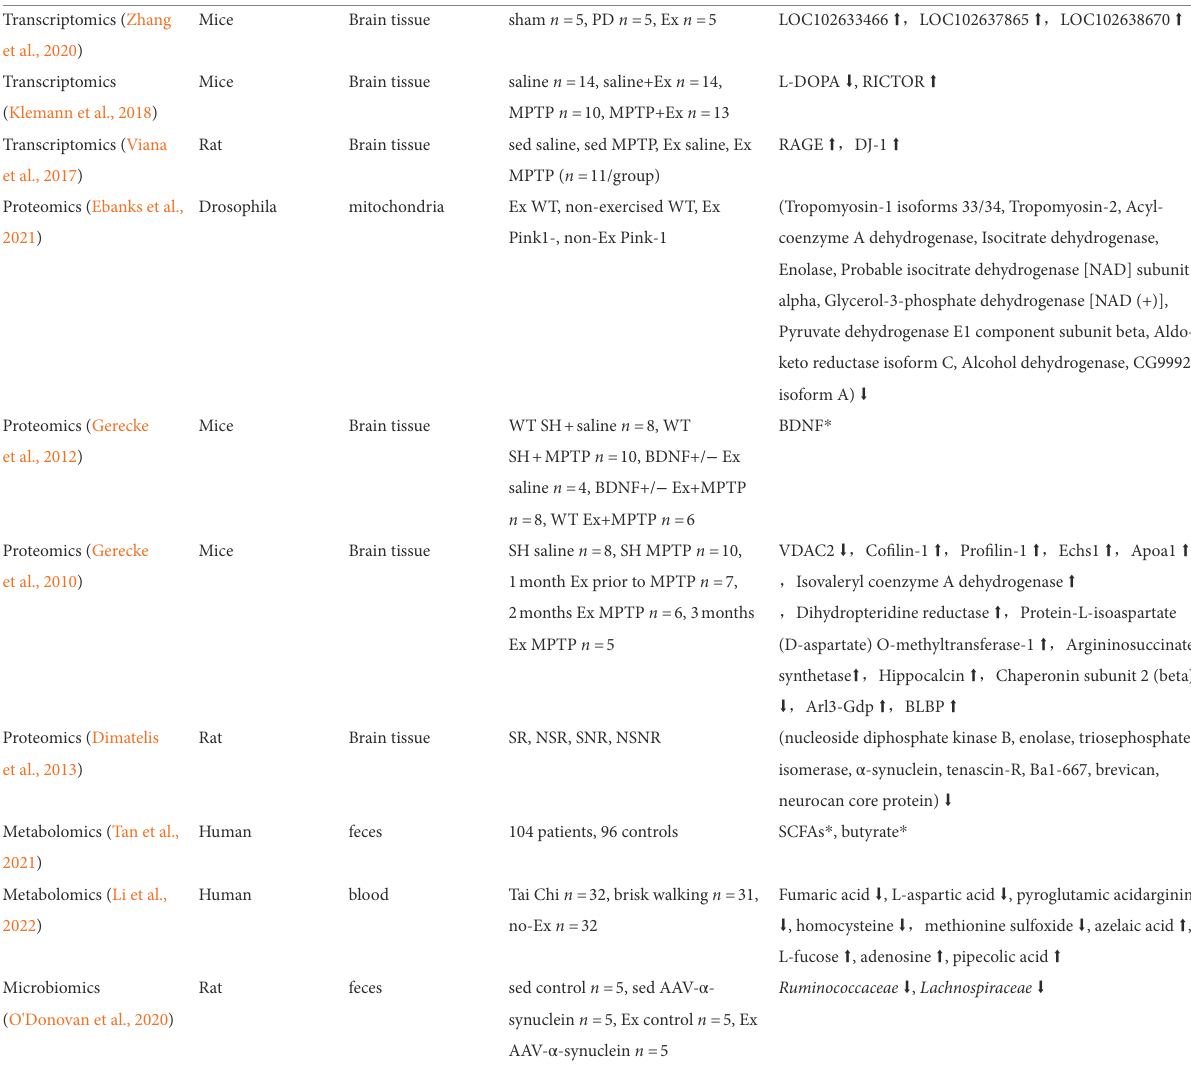
TABLE 2 Multi-omics studies of exercise and